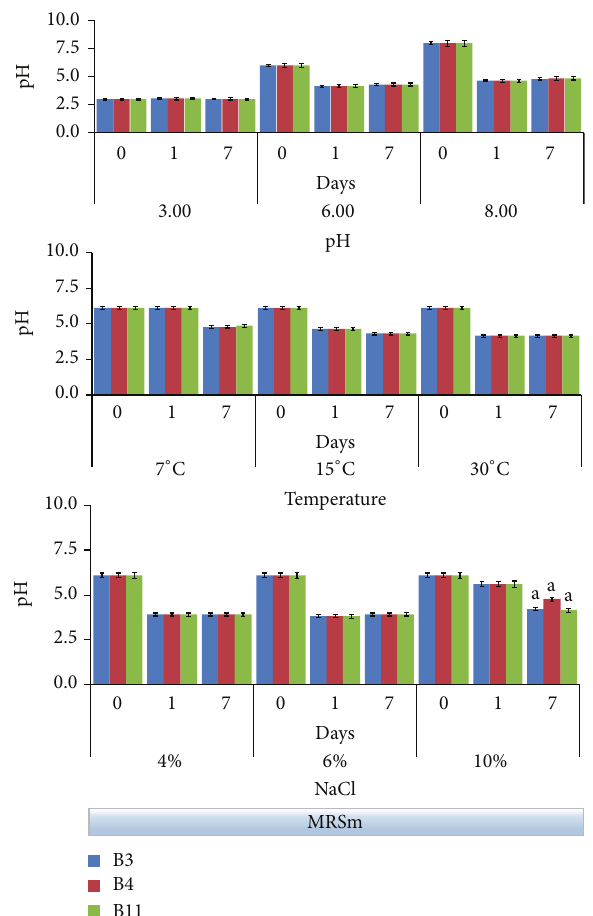
Figure 3: pH evolution in MRSm (modified MRS containing 1% glucose) followed up to 7 days under the following fermentation conditions: pH (3.0, 6.0, and 8.0), temperature (7, 15, and 30 ∘ C) and NaCl concentration (4, 6, and 10%). Data represent the mean and standard deviation of three independent replicates. Only the differences resulting as statistically significant ( 𝑝 < 0.01 ) are indicated with different letters. 30 ∘ C incubation temperature; initial pH